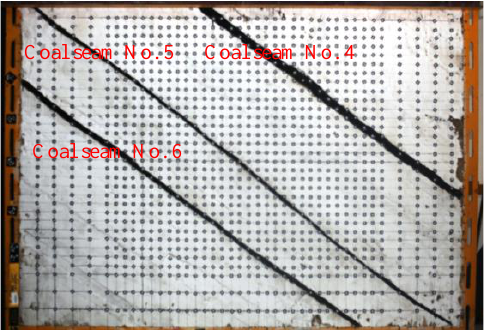
Figure 4. Similarity model for real-time monitoring of the stress state of the protected seam during the mining of multiple protective seams.